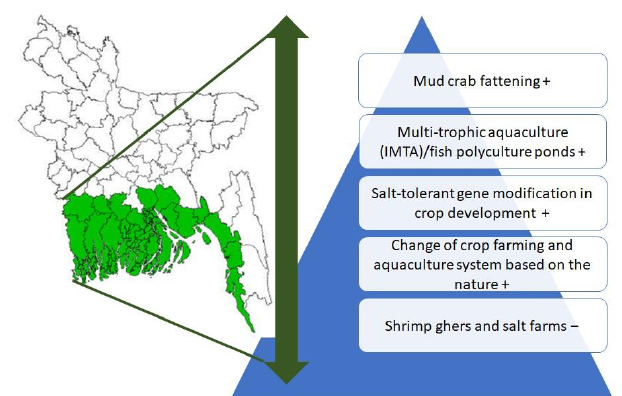
Figure 6. A conceptual model for changing aquaculture and farming systems modified to suit the environment and climate change adaptation based on a solution of nature-based local resources. + means a positive environmental impact while ‒ means a broadly negative environmental impact.